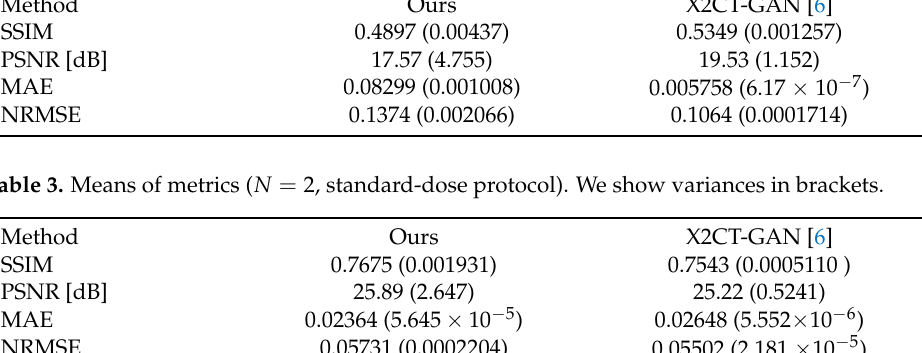
Table 2. Means of metrics ( N = 1, standard-dose protocol). We show variances in brackets. Method